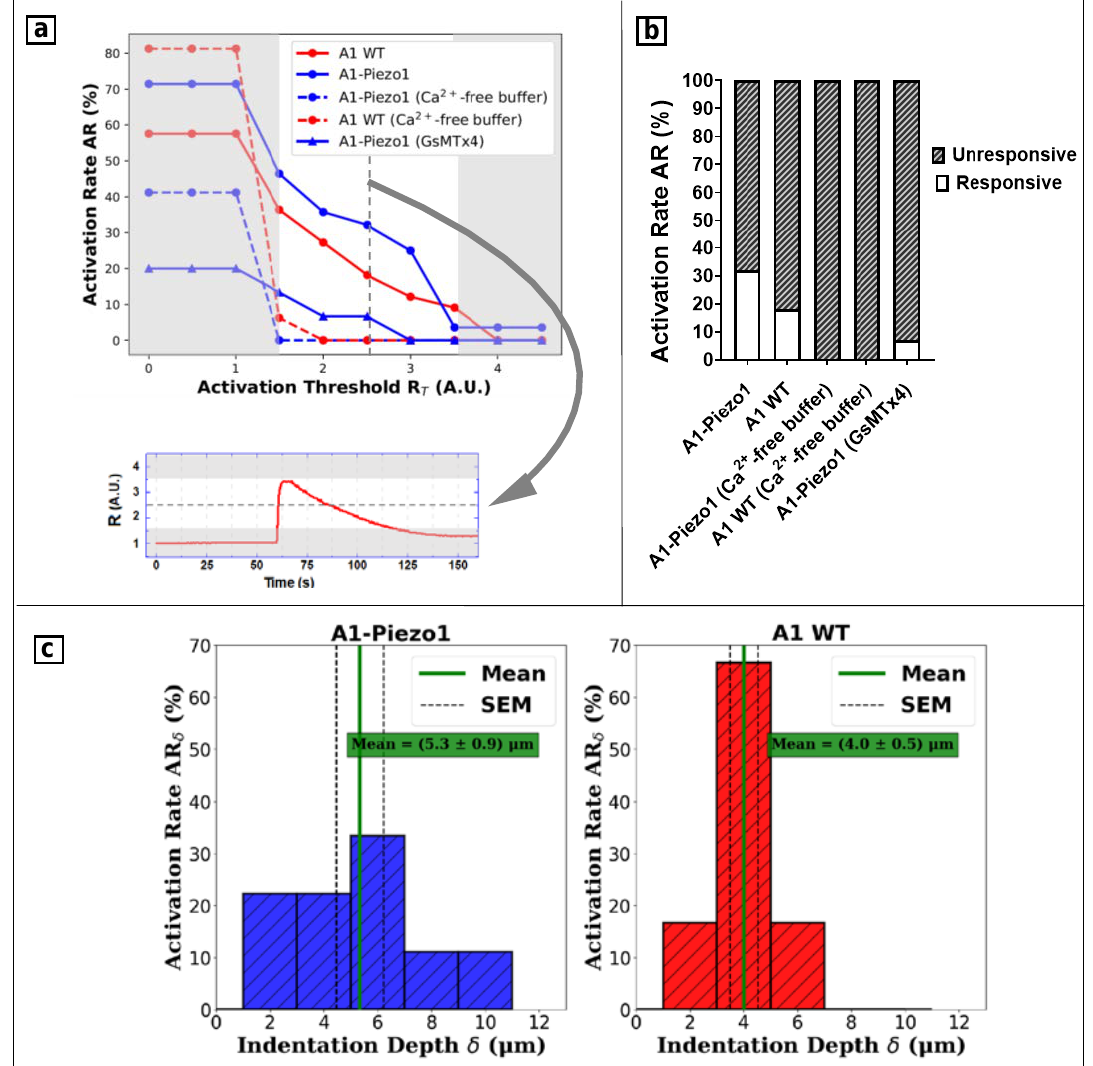
Figure 6. Data analysis and device validation. Assessment of cell responsivity requires setting a proper fluorescence ratio threshold R T . Among activated cells, average indentation depth δ obtained from each group provides a calibration parameter. ( a ) Relationship between activation rate AR and the activation threshold R T used for classification; extreme values of threshold R T (grey area) were excluded to avoid misleading values of AR, and the median R T = 2.5 was selected for evaluating inter- group AR. ( b ) AR among different A1 cell groups. ( c ) Histogram showing the depth of indentation δ associated to the response event rate AR δ for A1-Piezo1 and A1